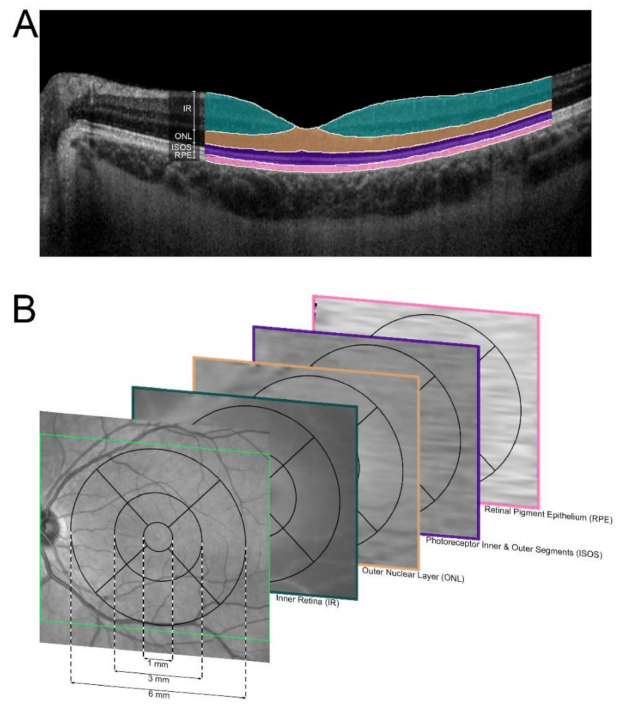
Figure 1. Image annotation and analysis. ( A ) Spectral-domain optical coherence tomography